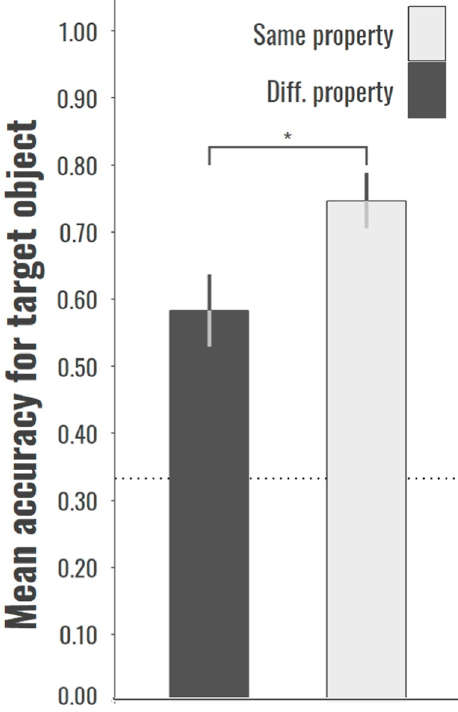
Figure 4. Mean accuracy for selecting the correct target object with the property that is the same as the exemplar object. Bootstrapped standard errors are shown as vertical lines, and the horizontal dotted line is chance performance at 0.33, and * indicates the significant difference.